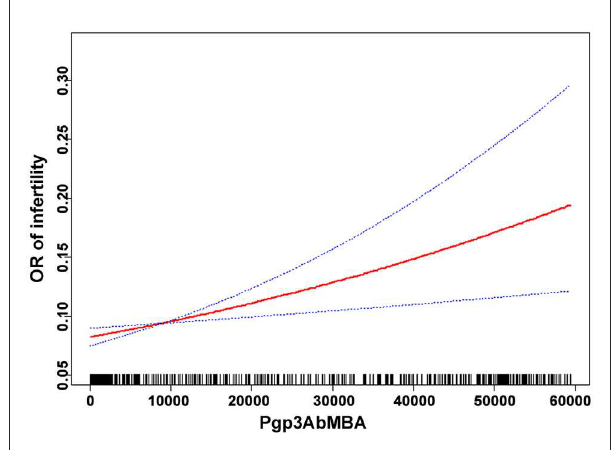
FIGURE2 The relationship between Pgp3AbMBA and infertility by smooth curve